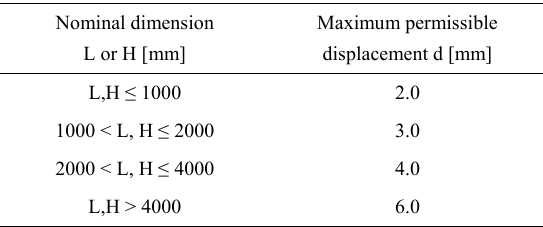
Table 1: Maximum edge displacement (ISO